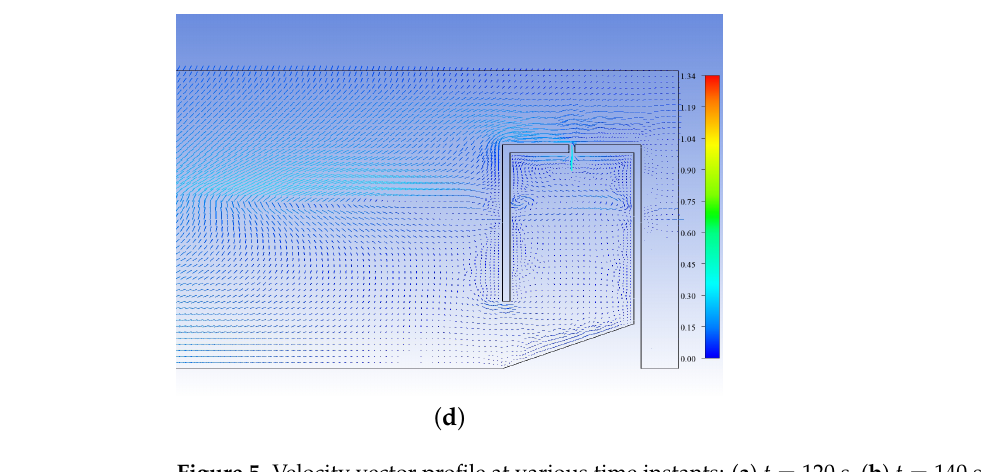
Figure 5. Velocity vector profile at various time instants: ( a ) t = 120 s, ( b ) t = 140 s, ( c ) t = 170 s, and